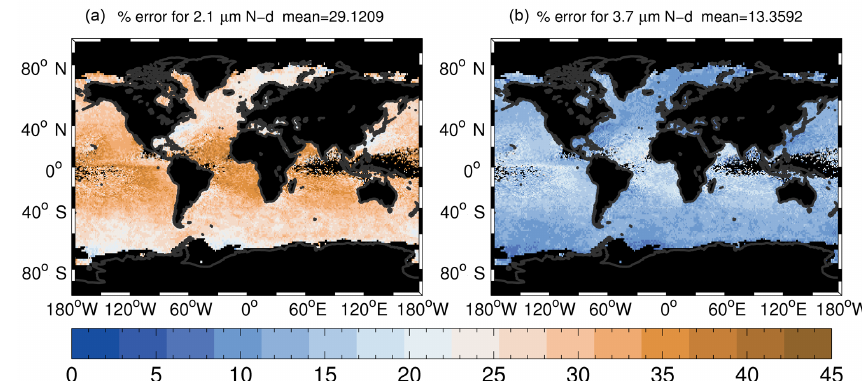
Figure 5. Maps of the annual mean percentage error for uncorrected N d retrievals using a year (2008) of daily MODIS data that have been filtered to select data points in which N d retrievals are favourable and therefore most likely to be used for N d data sets (see text for details). The left plot shows the results for the r e2.1 retrieval and the right for the r e3.7 retrieval.